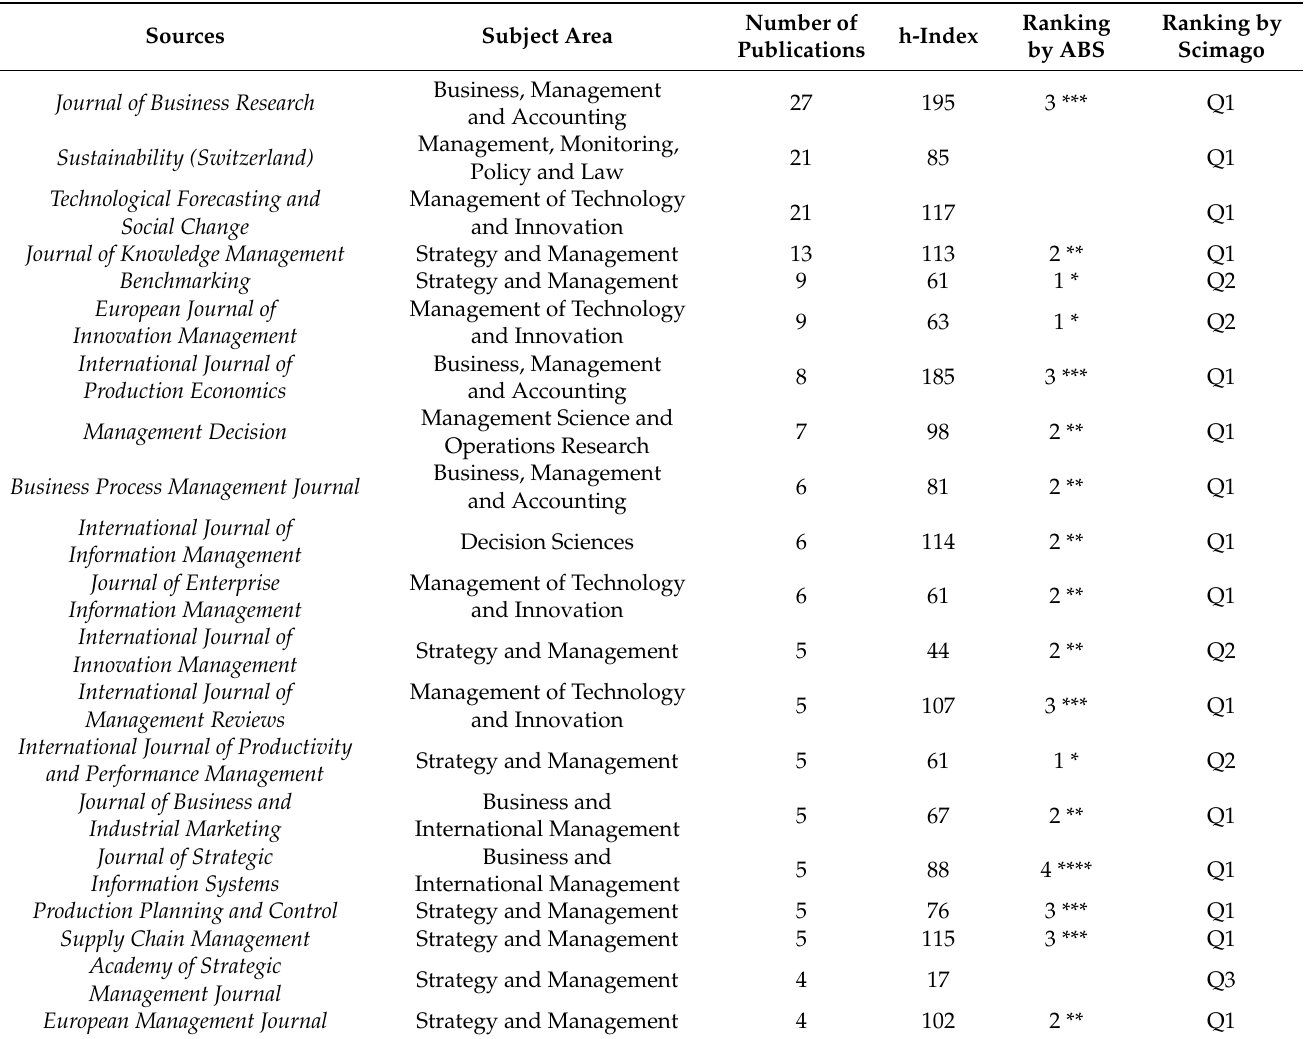
Table 1. Most relevant publications in the field of ambidexterity and